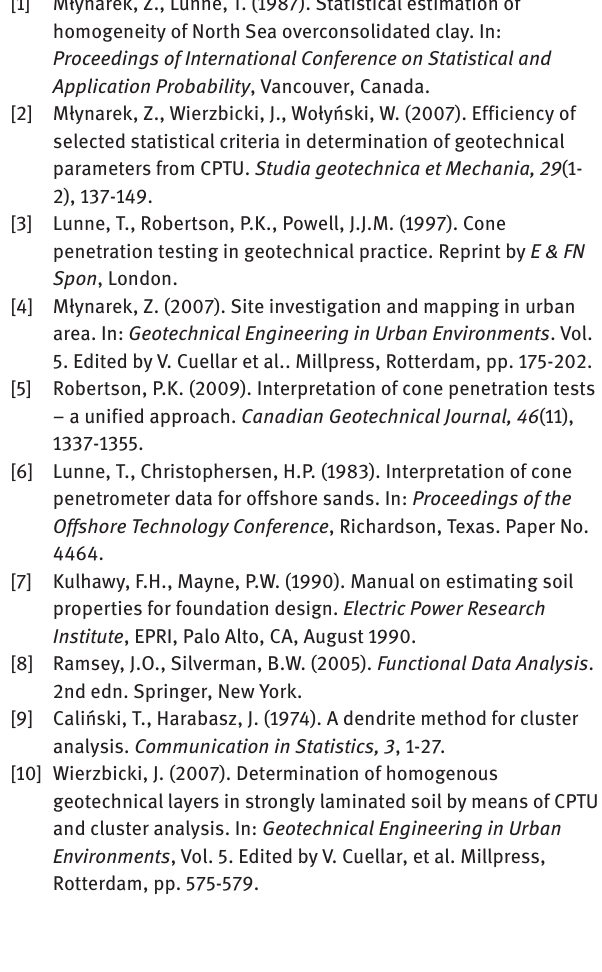
of a model based on mean values of modulus M, the